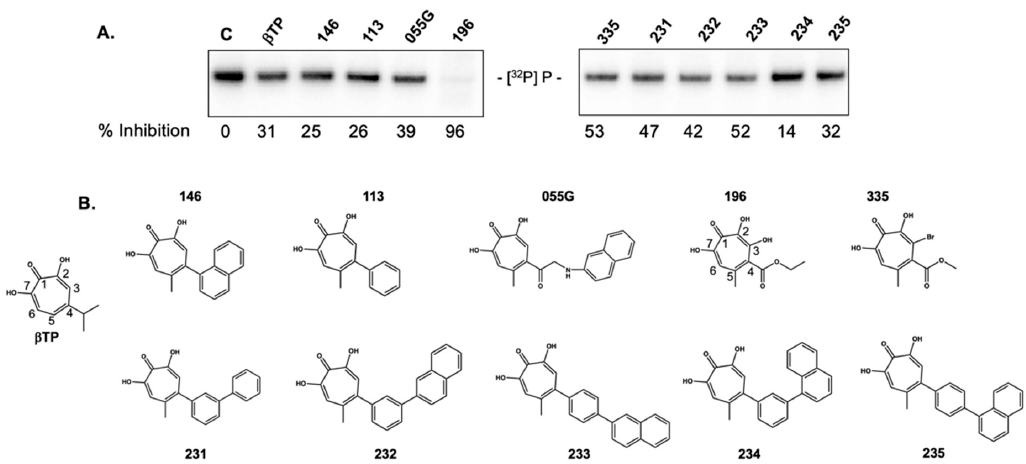
Figure 3. Sensitivity of ε -dependent initiation of HBV minus-strand DNA synthesis to α -HT and 3,7-dHT inhibitors previously shown to inhibit HBV and HIV RNase H activity. ( A ) Protein-primed, ε -dependent initiation of HBV minus-strand DNA synthesis. % inhibition at a ligand concentration of 100 µ M is provided. ( B ) α -HT and 3,7-dHT structures. β TP, β -thujaplicinol. Ring numbering of β TP and the sole 3,7-dHT, 196 , has been provided for